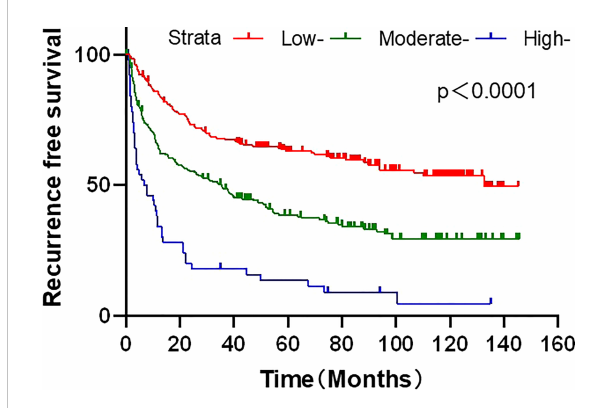
FIGURE 6 Risk strati fi cation of the developed nomogram model for recurrence free